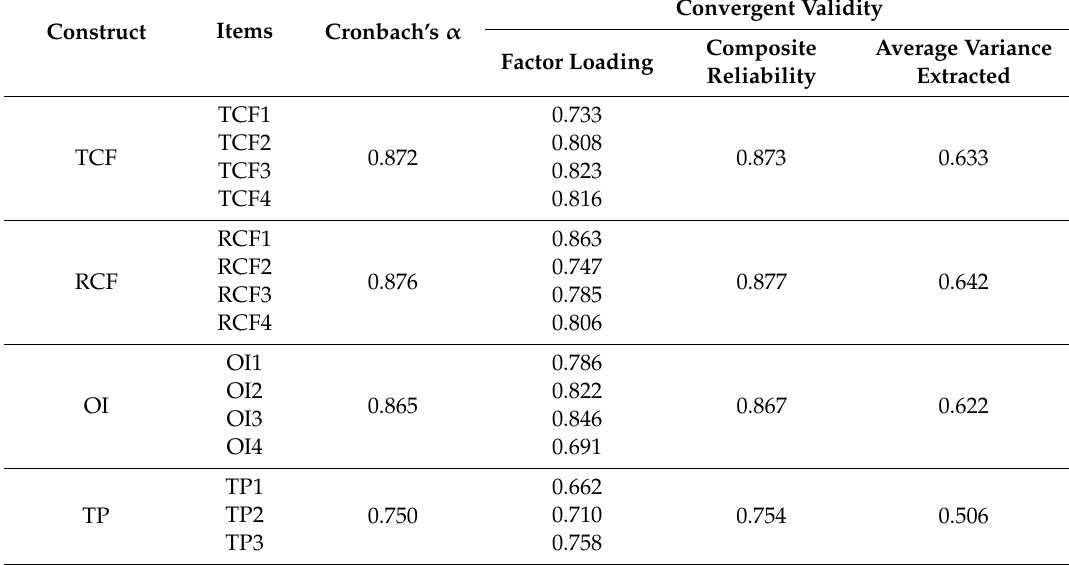
Table 4. Test results of internal reliability and convergent